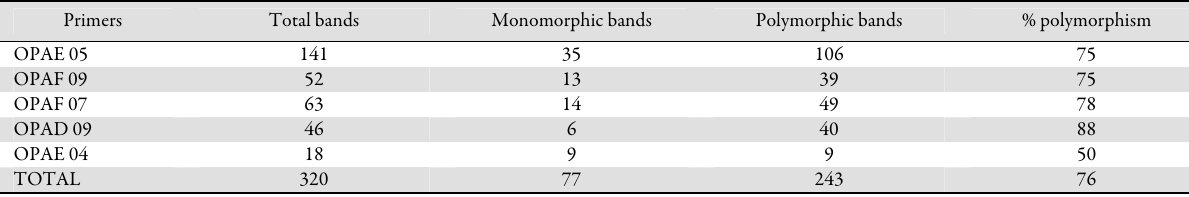
Table 2. Total bands scored by the primers and their percentage polymorphism